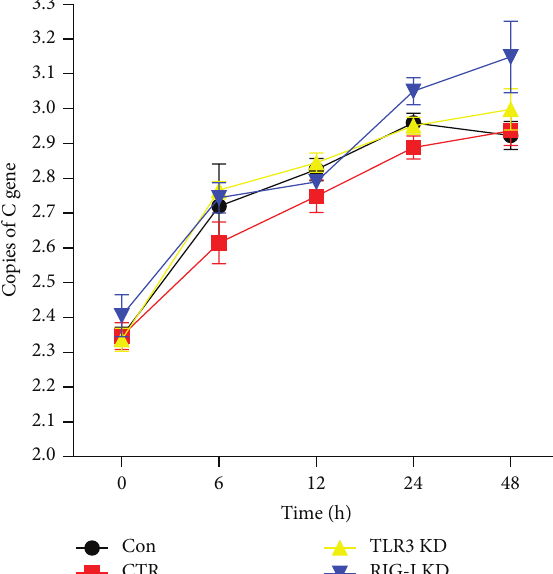
Figure 10: Viral load in TLR3 and RIG-I knockdown cells. BV-2 cells were transfected with RIG-I shRNA (RIG-I KD), TLR3 shRNA (TLR3 KD), or negative control shRNA (CTR) and then infected with JEV at an MOI of 0.01. Cells were collected at different time points, and total RNA was isolated. The number of copies of the JEV C gene was determined with qRT-PCR. Error bars represent the mean ± standard error from three independent